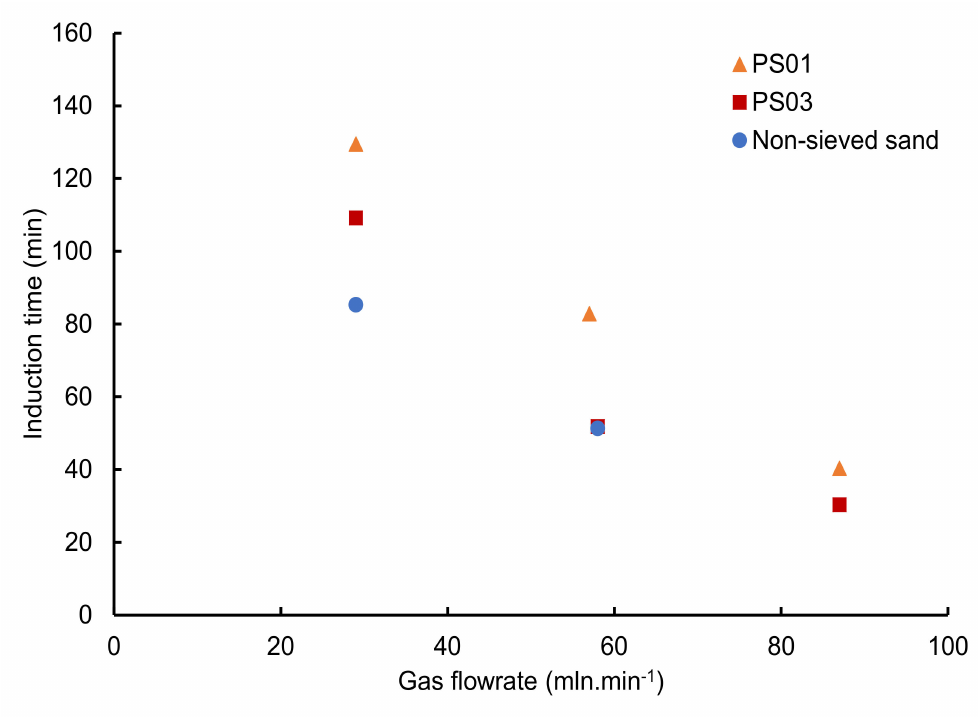
Figure 11. Induction time as a function of gas flowrate for a water saturation around